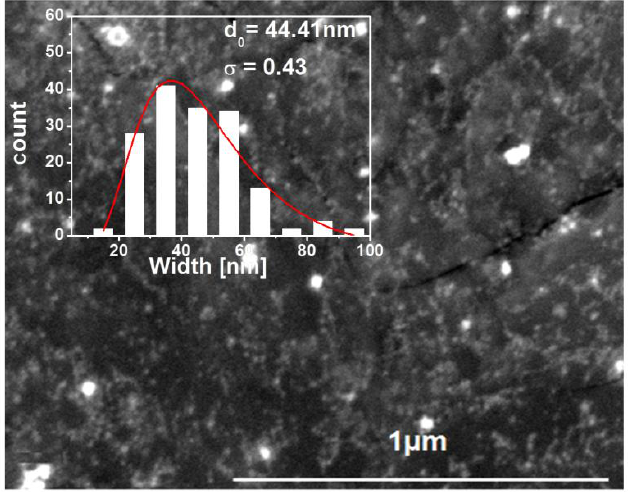
Figure 5. EDS graph of the WO